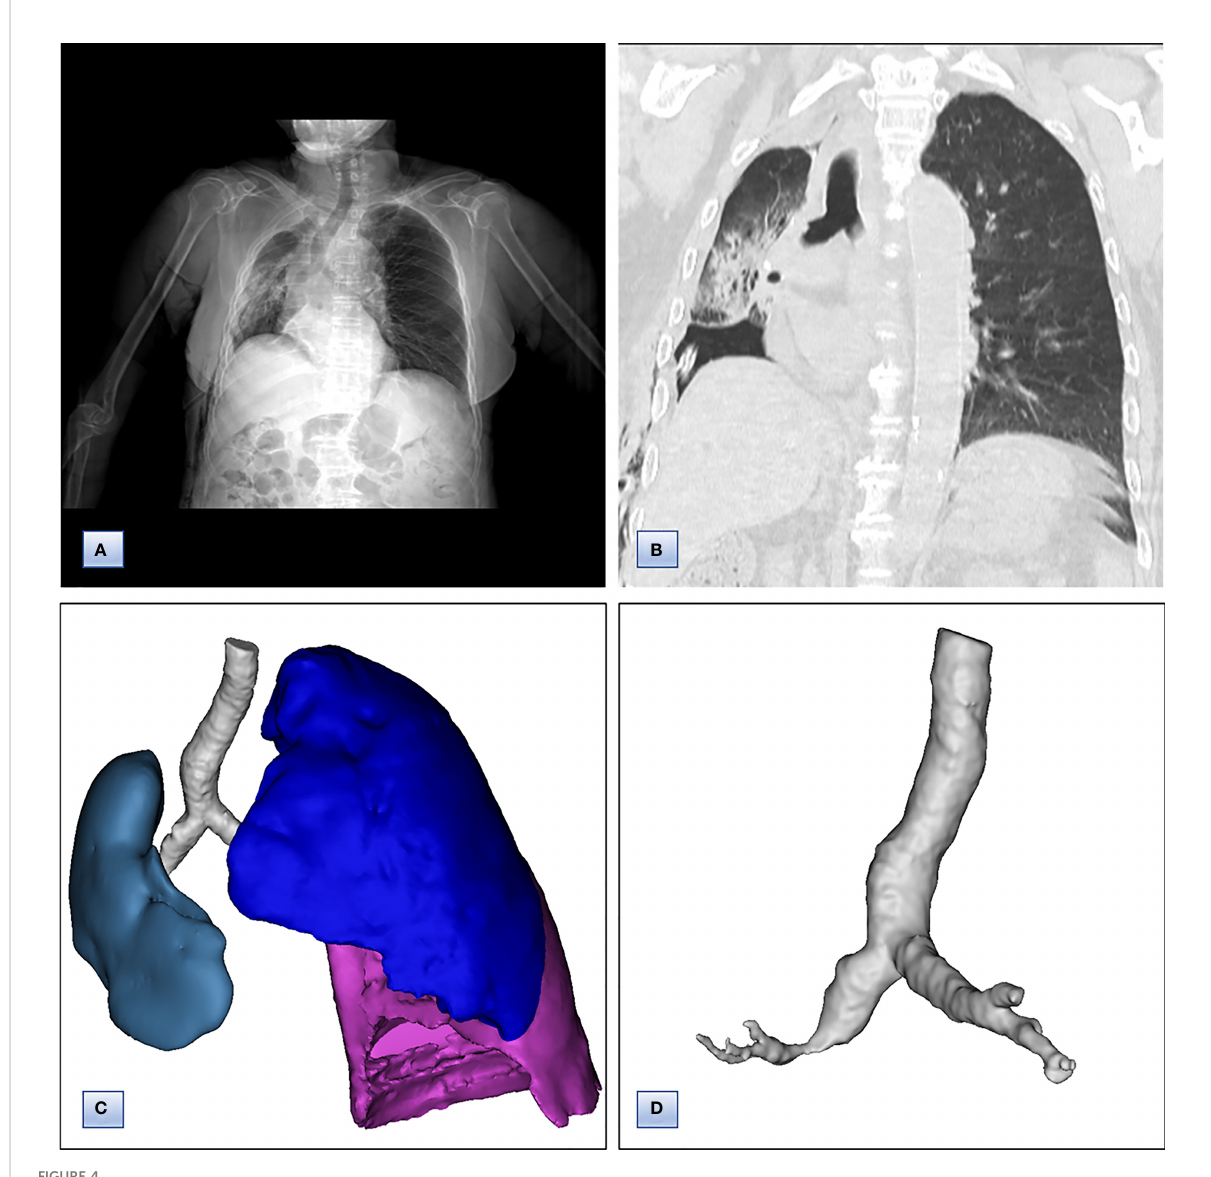
FIGURE 4 Chest computed tomography and7 3D CT reconstruction after surgery. (A) Chest CT, revealing that the trachea and mediastinum were more obviously shifted to right than that before surgery. (B) Coronal chest CT images, indicating adequate recruitment of the right middle lobe. (C, D) 3D reconstruction of CT images, showing (C) only middle lobe in right thoracic cavity and (D) unobstructed bronchus of right middle